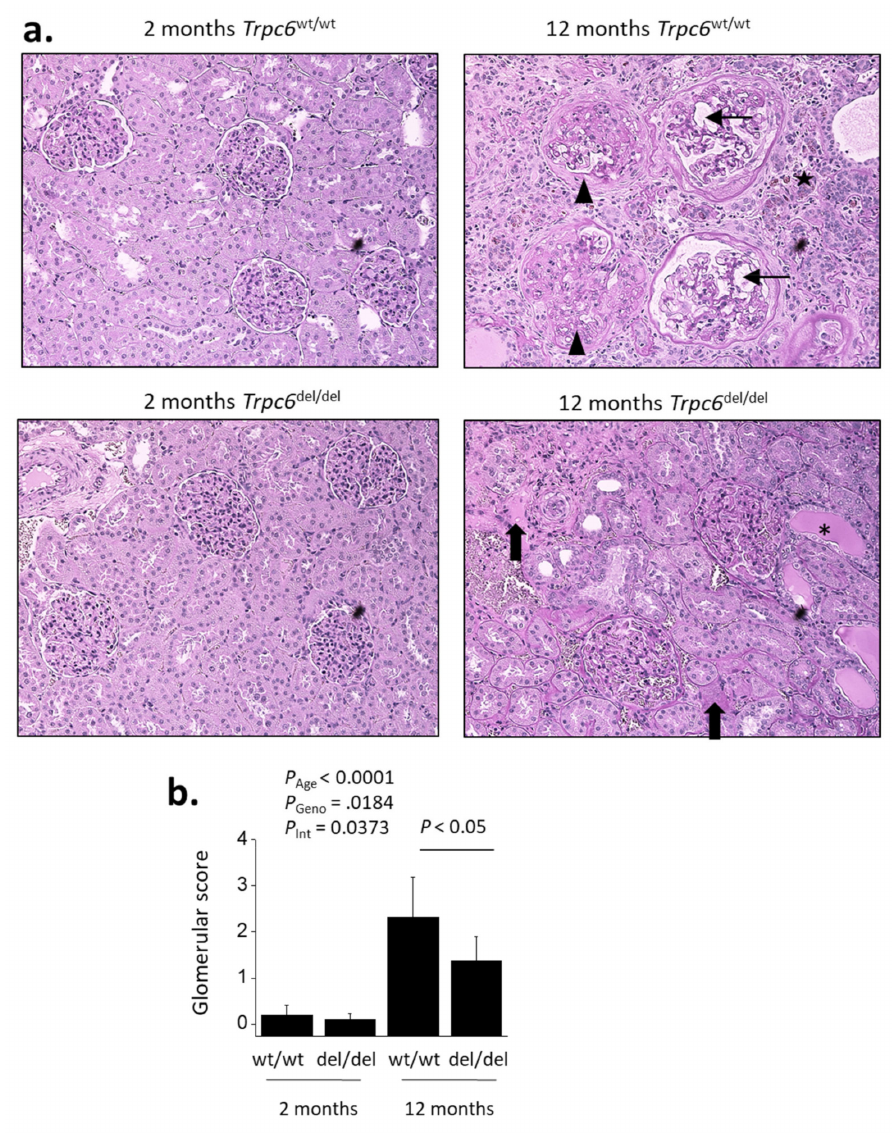
Figure 5. TRPC6 inactivation reduces age-related increases in glomerulosclerosis. Representative sections stained by periodic acid–Schiff’s method are shown in ( a ). Histology of renal cortex is normal in 2-month-old animals regardless of genotype. By contrast, glomerulosclerosis and tubuloin- terstitial disease could be seen in all 12-month-old animals. Note collapsed and sclerotic glomeruli (arrowheads) and dilated capillary loops (small arrows) in this section from a Trpc6 wt/wt rat, as well as regions of cellular infiltration (star). Glomerulosclerosis was less severe and fewer glomeruli were affected in Trpc6 del/del animals, as can be seen in the section from the Trpc6 del/del rat. Nevertheless, kidney disease was always present regardless of genotype. Note presence of protein casts in tubules (asterisks) and regions of tubulointerstitial fibrosis (large arrow) in the section from the Trpc6 del/del rat. These types of images were scored semi-quantitatively by an observer blind to each treatment group for the severity of glomerulosclerosis based on analyses of at least 30 glomeruli from each ani- mal ( b ). These scores reflect only the condition of the glomeruli. Two-way ANOVA revealed robust effects of age on mean glomerular score ( p < 0.001). There were also significant effects of genotype ( p = 0.0184) and a significant interaction effect ( p = 0.0373) between genotype and age-related changes in glomerulosclerosis. Data are from 6 animals in each group. Bar graphs denote mean ±